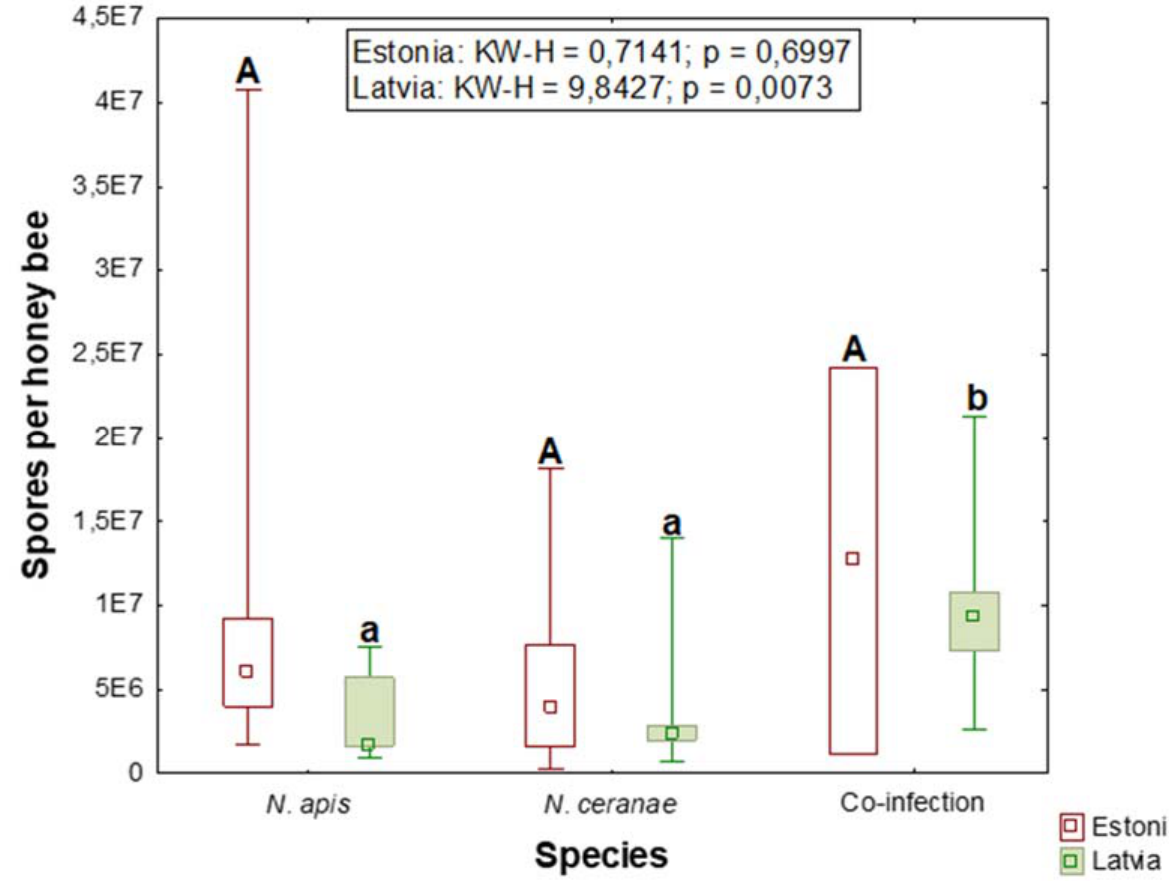
Figure 2. Bar graphs depicting the numbers of Nosema spores per honey bee in samples from Estonian and Latvian apiaries, as measured using flow cytometry. Error bars are the minimums and maximums. Columns with different letters indicate significant differences. Statistical differences were calculated by the Kruskal-Wallis test, with significance set at p < 0.05.